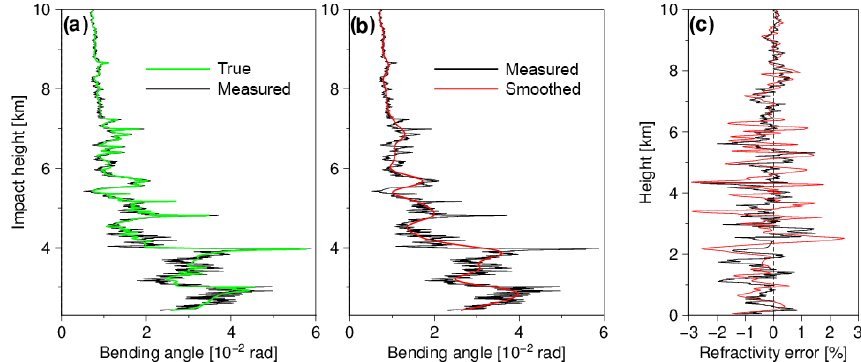
Figure 4. Simulated bending angles and their errors propagated into the refractivity via Abel inversion. (a–b) Green line (denoted TRUE) indicates the bending angle modeled with the exact refractivity profile shown in Fig. 3c; black line (MEASURED) represents the “measured” bending angle for which assumed measurement errors are added to the perfect bending angle; red line (SMOOTHED) denotes a low-pass filtered version of the MEASURED. Note that the black line in panel (b) , which is the same as that in panel (a) , is duplicated to ease the comparison. (c) Errors in the refractivity; the refractivity profiles are obtained from the bending angle of matching color via Abel inversion and the error is defined as the difference from the perfect refractivity, which is the one derived from the TRUE bending angle. See text for more